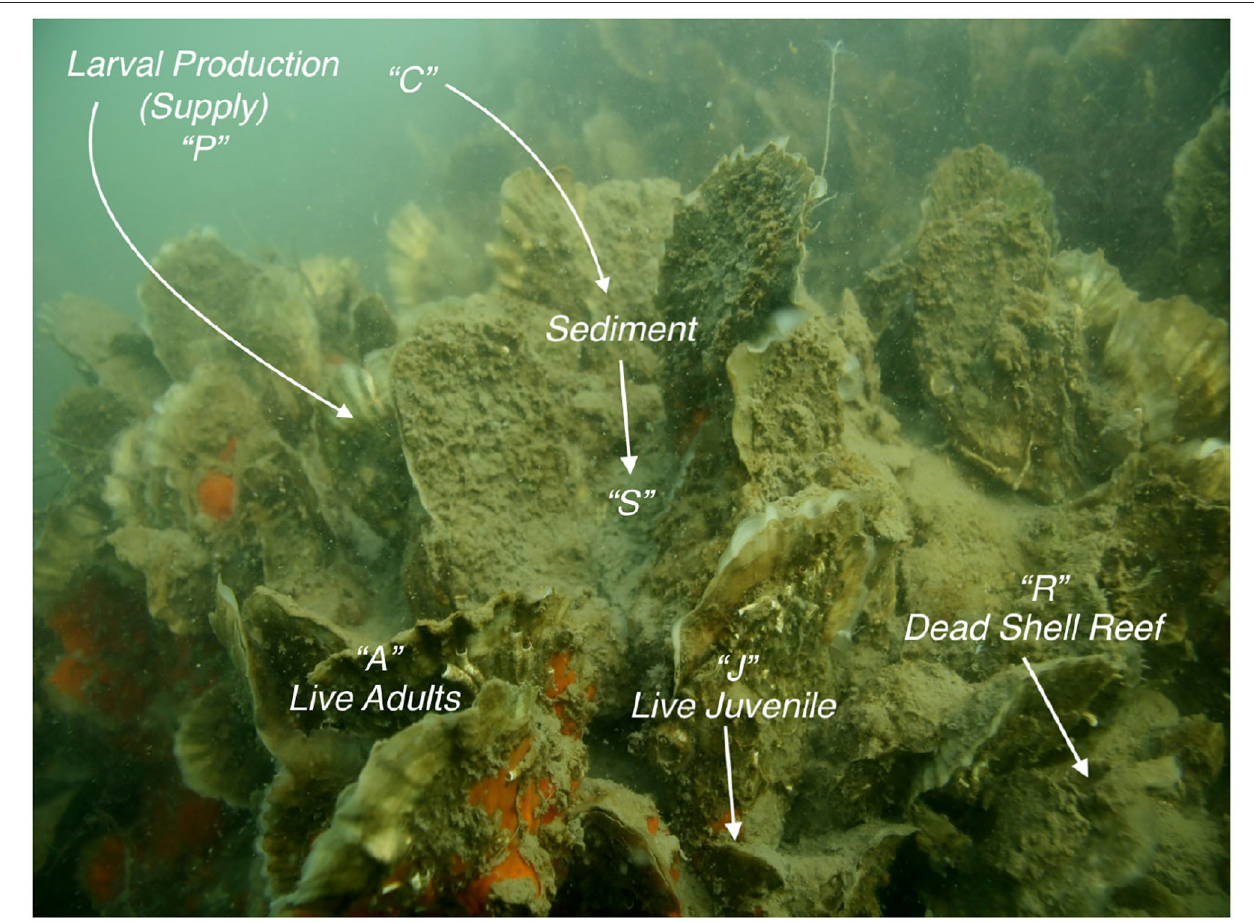
FIGURE 1 | Representation of the main elements of the stage-structured JARS model; letters above each element match those in the model. Larval production P , larval supply, which includes larvae both from the natal population and from outside populations. C , water-column sediment concentration before being deposited on the reef. Photo by Stopher Slade; https://ncseagrant.ncsu.edu/coastwatch/previous-issues/2017-2/holiday-2017/making-the-most-of-oyster-reef-filtering/.